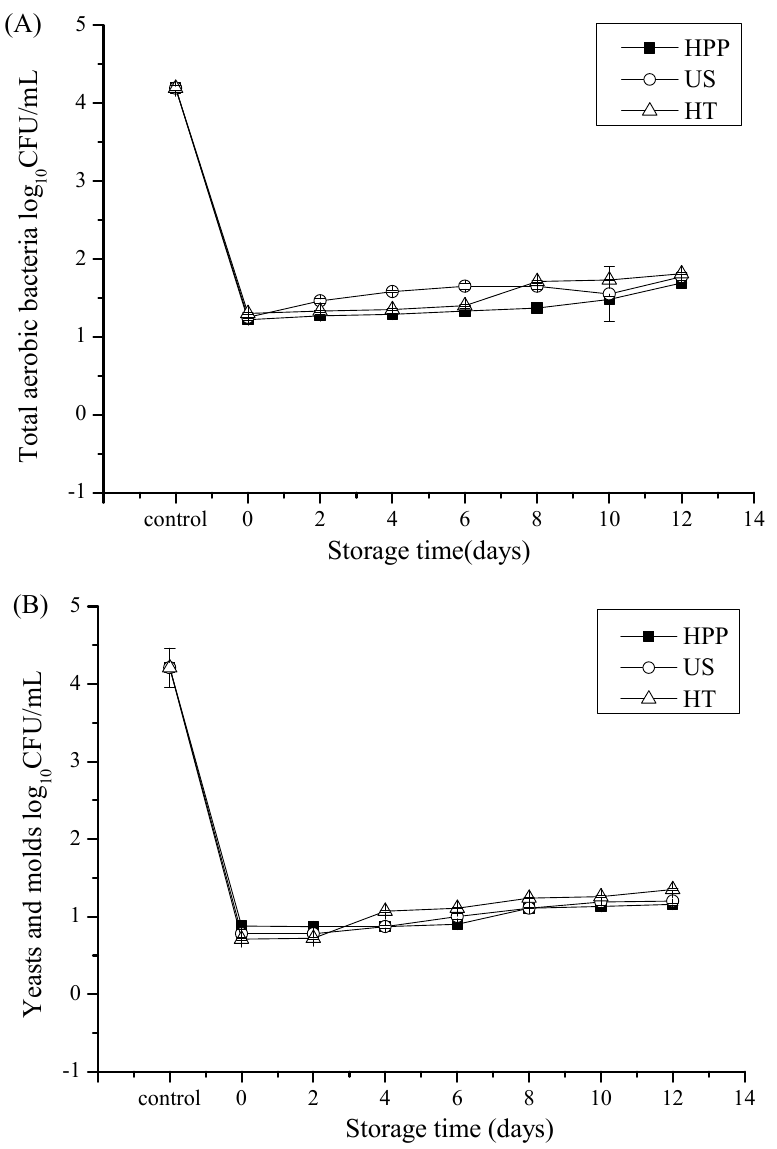
Figure 1. Changes in the total aerobic bacteria ( A ) and yeast and mold ( B ) counts in juice blends treated by HHP, US, and HT after 12 days of storage at 4 ◦ C. HHP: high hydrostatic pressure (500 MPa / 15 min / 15 ◦ C), US: ultrasound (376 W / 10 min / 35 ◦ C), HT: heat treatment (86 ◦ C / 1 Table 1. Variations of coliforms (MPN/100 mL) in juice blends treated by HHP, US, and HT after 12 days of storage at 4 °C.